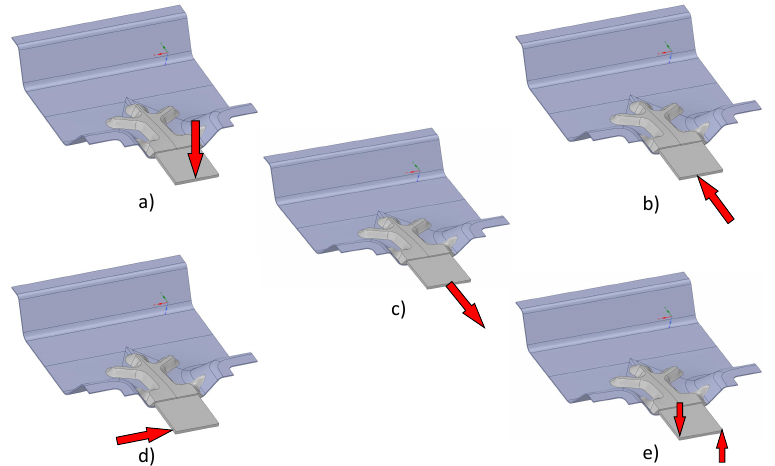
Figure 3. Forces applied to the metal inlay. ( a ) bending, ( b ) compression, ( c ) traction load, ( d ) lateral bending, ( e ) torsion.